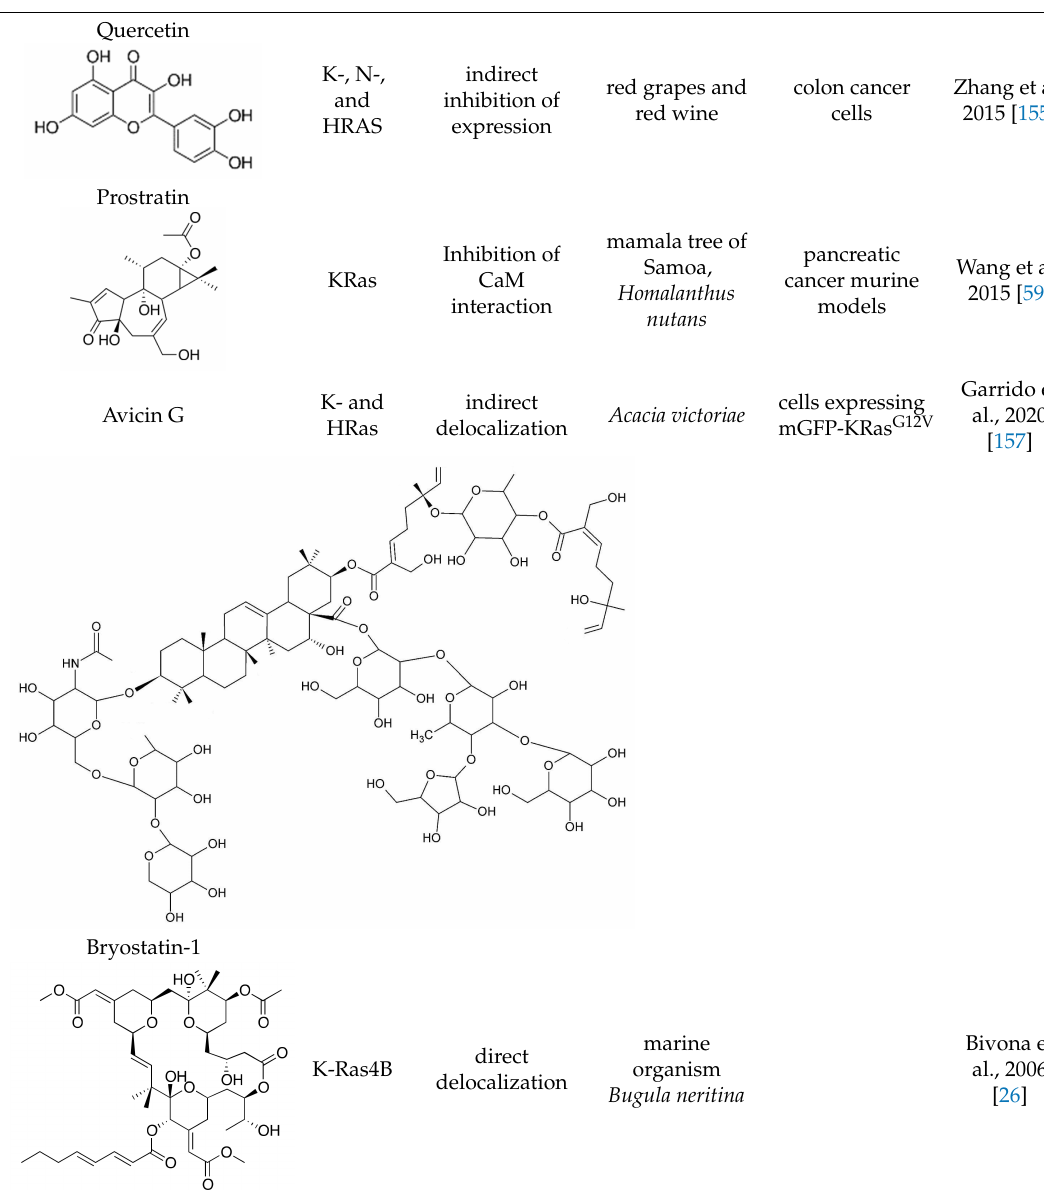
Table 1. List of natural compounds indirectly a ff ecting Ras oncoproteins activity.